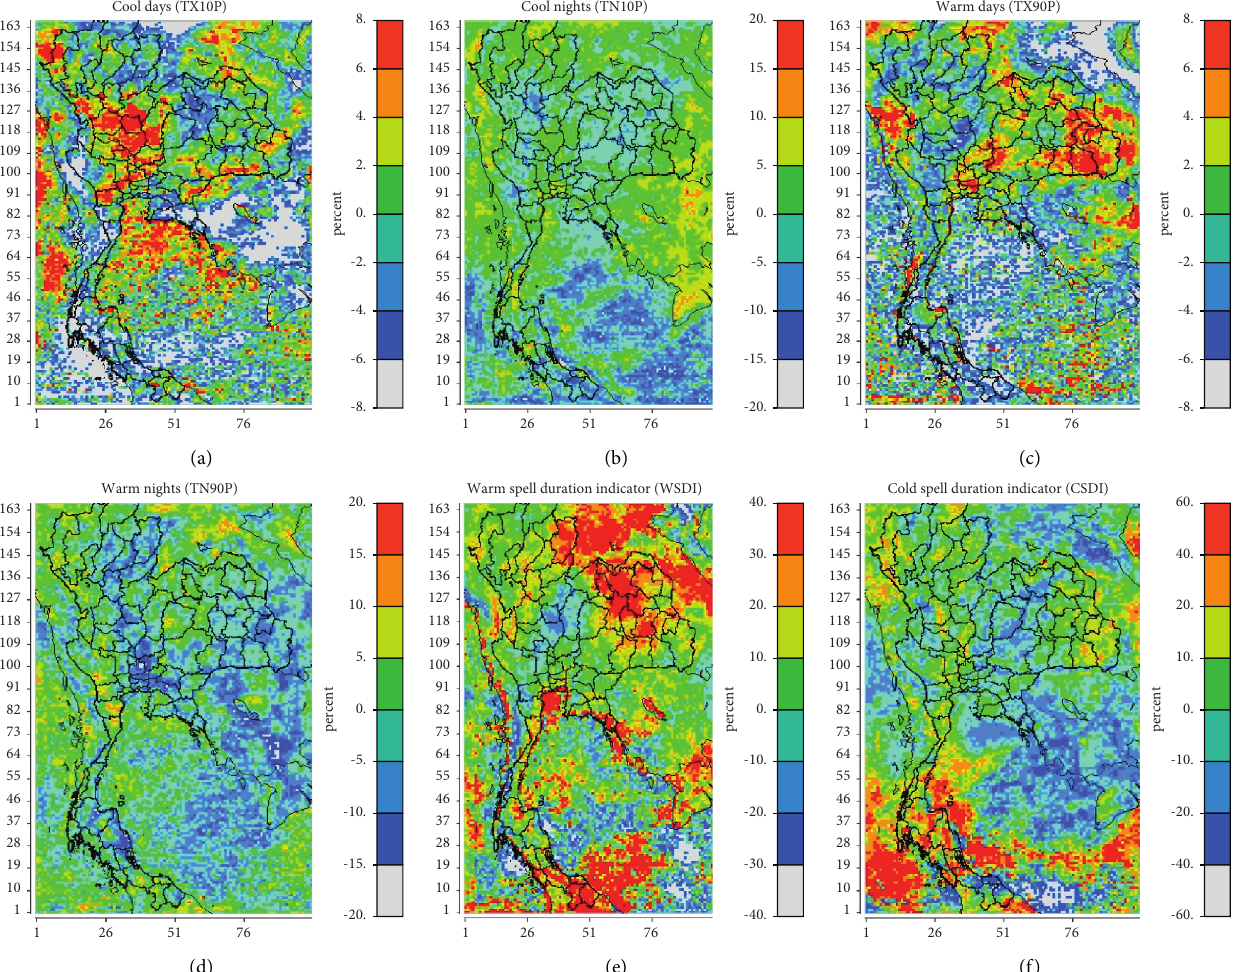
Figure 3: Spatial distribution of percentage differences in (a) TX10P, (b) TN10P, (c) TX90P, (d) TN90P, (e) WSDI, and (f) DSDI between years 2020 and 2029 and between years 1990 and 1999 in